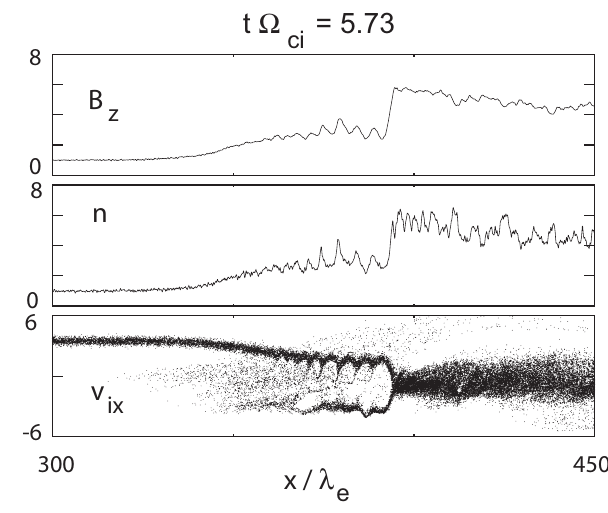
Fig. 2. From top to bottom: magnetic field B z component, ion density n i , and ion v ix phase space versus shock normal direction x for the ion to electron mass ratio 1024 run.